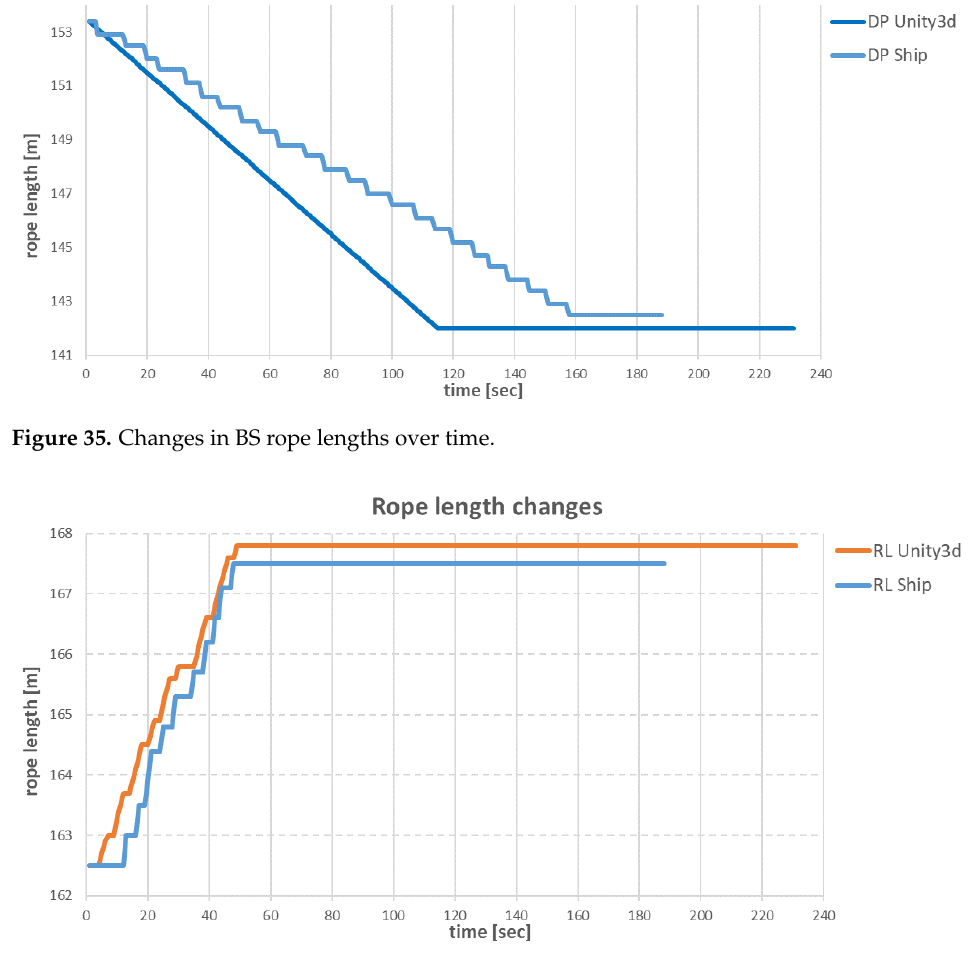
Figure 36. Changes in SP rope lengths over time.